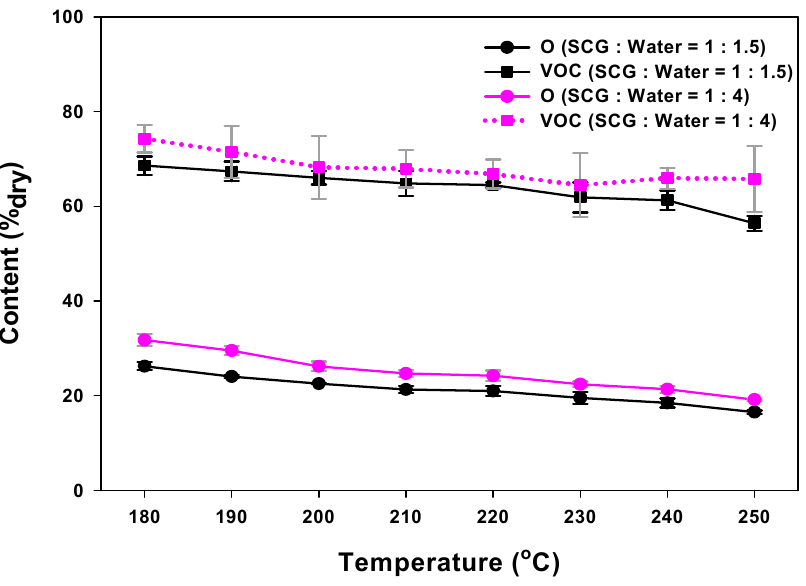
Figure 5. Amount of carbon and fixed carbon compounds in SCGs produced with different reaction temperatures and water contents.